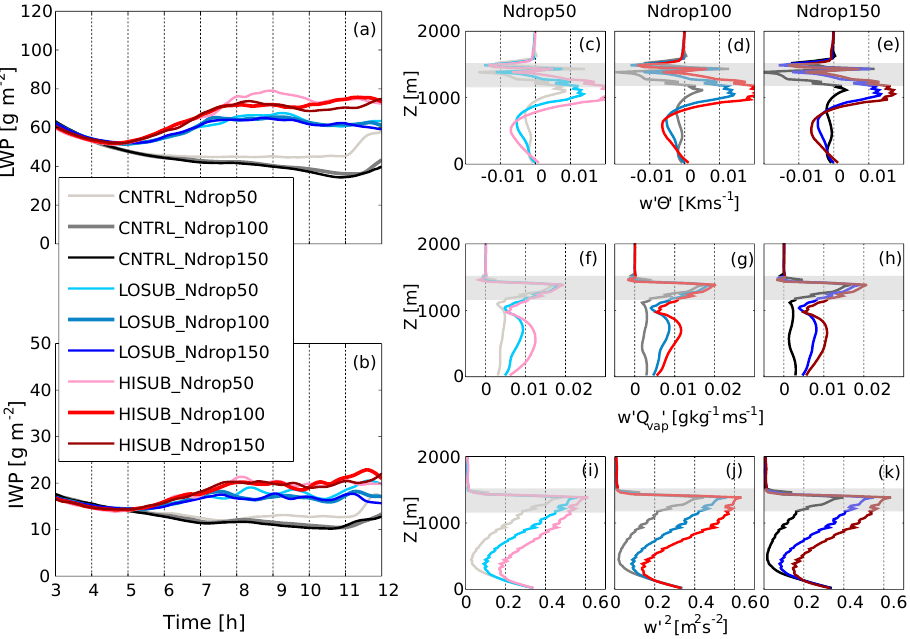
Figure 4. Domain-averaged LWP (a) and IWP (b) time series for simulations with different N drop whilst varying the imposed W sub . Black: control cases; blue: low W sub ; red: high W sub . (c–e) buoyancy flux ( w (cid:48) (cid:50) (cid:48) ), (f–h) water vapour flux ( w (cid:48) Q (cid:48) vap ), (i–k) vertical ve- locity variance ( w (cid:48) 2 ). Vertical profiles shown at